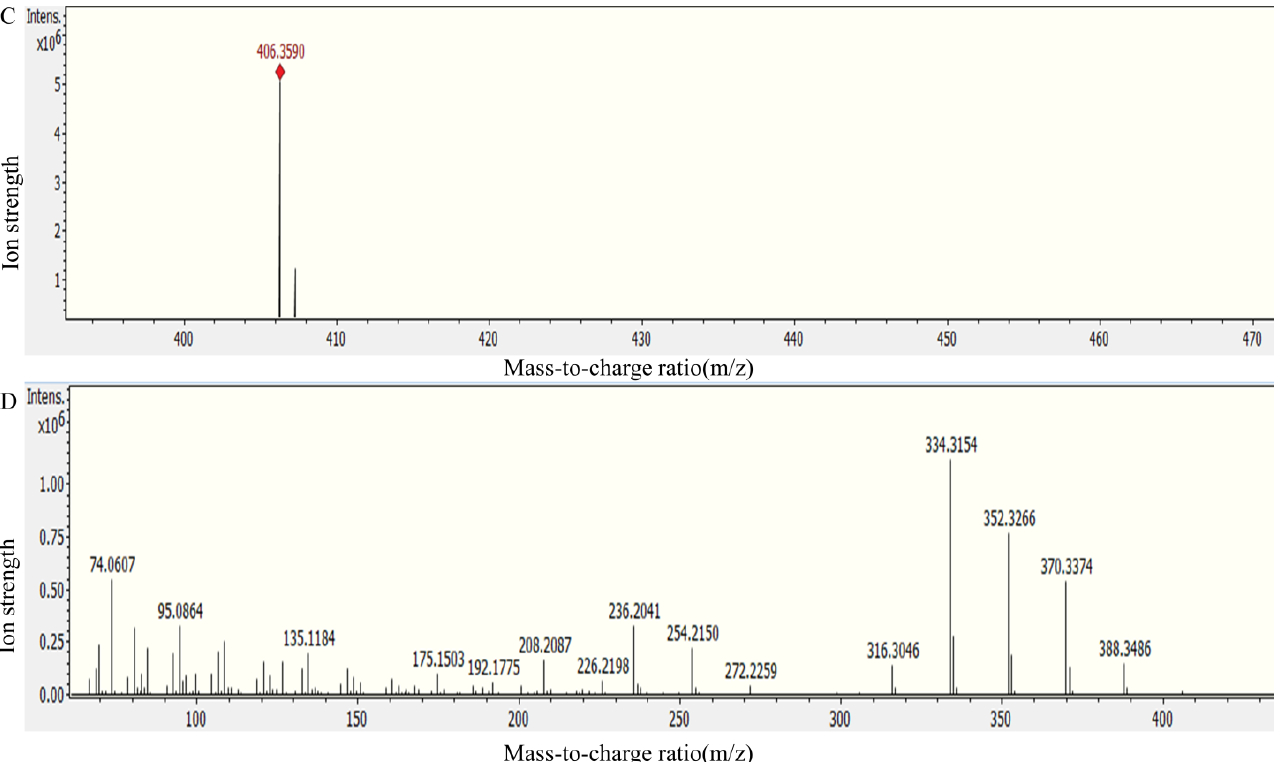
Figure 8. Mass spectrum of HFB1. ( A ) Total ion flow diagram; ( B ) The EIC chart of HFB1; ( C ) The primary mass spectrum of HFB1; ( D ) The secondary mass spectrum of HFB1.